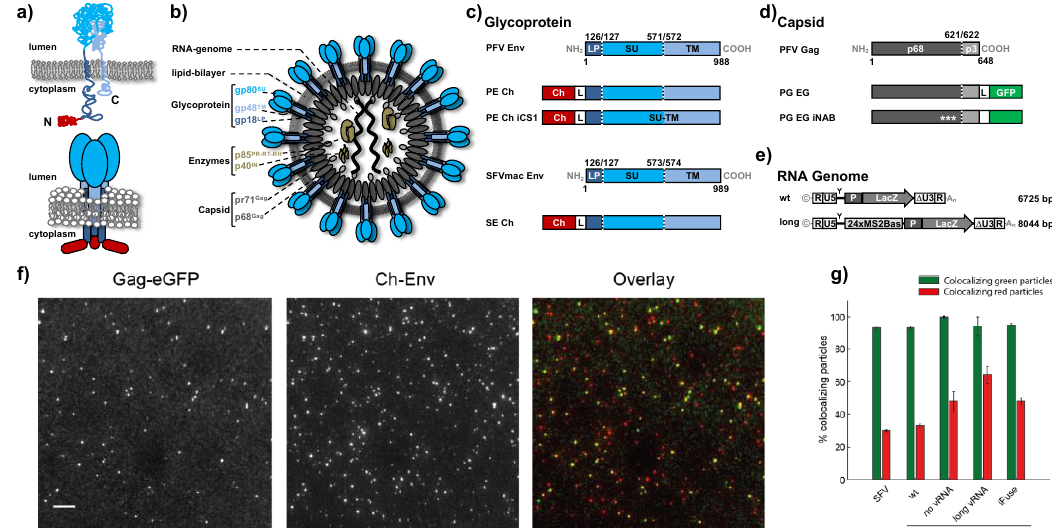
Figure 1. Characterization of the virus particles used in this study. ( a ) Schematic illustration of the prototype foamy viruses (PFV) Env membrane topology at the state of the precursor (upper graphic) and oligomeric, mature glycoprotein complex (lower graphic). Color coding of the individual domains or subunits is indicated in panels ( b – e ). ( b ) Schematic representation of the PFV particle structure. pr: precursor protein; p: protein; gp: glycoprotein; gp18 LP : Env leader peptide subunit; p85 PR-RT-RH : Pol protease-reverse-transcriptase-RNaseH subunit; p40 IN : Pol integrase subunit; pr71 Gag : Gag precursor; p68 Gag : Gag p68 subunit. ( c – e ) Schematic outline of the PFV Gag, PFV, or macaque simian foamy virus (SFVmac) Env, and PFV vector genome variants. Graphical illustration of the PFV Gag and PFV or SFVmac Env protein structure as well as the PFV viral genome structure of the di ff erent variants employed in this study. Numbers indicate the amino acid positions and the subunit processing sites within the translated precursor proteins are indicated by dashed lines. The viral RNA genome sizes are given in base pairs. NH 2 : N-terminus; COOH: C-terminus; LP: Env leader